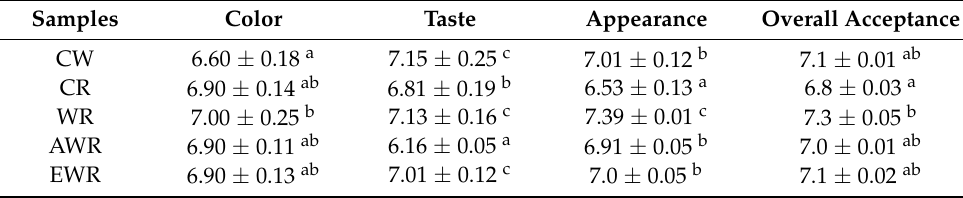
Table 5. The effect of in situ-formed EPS on sensory evaluation of sourdough bread. Samples Color Taste Appearance Overall